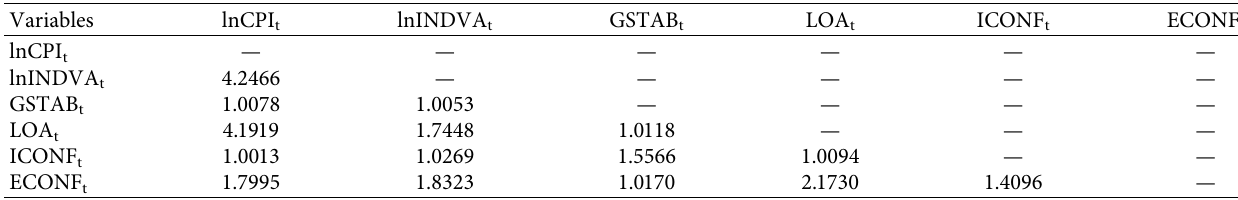
Table 3: Matrix of variance inflation factor.